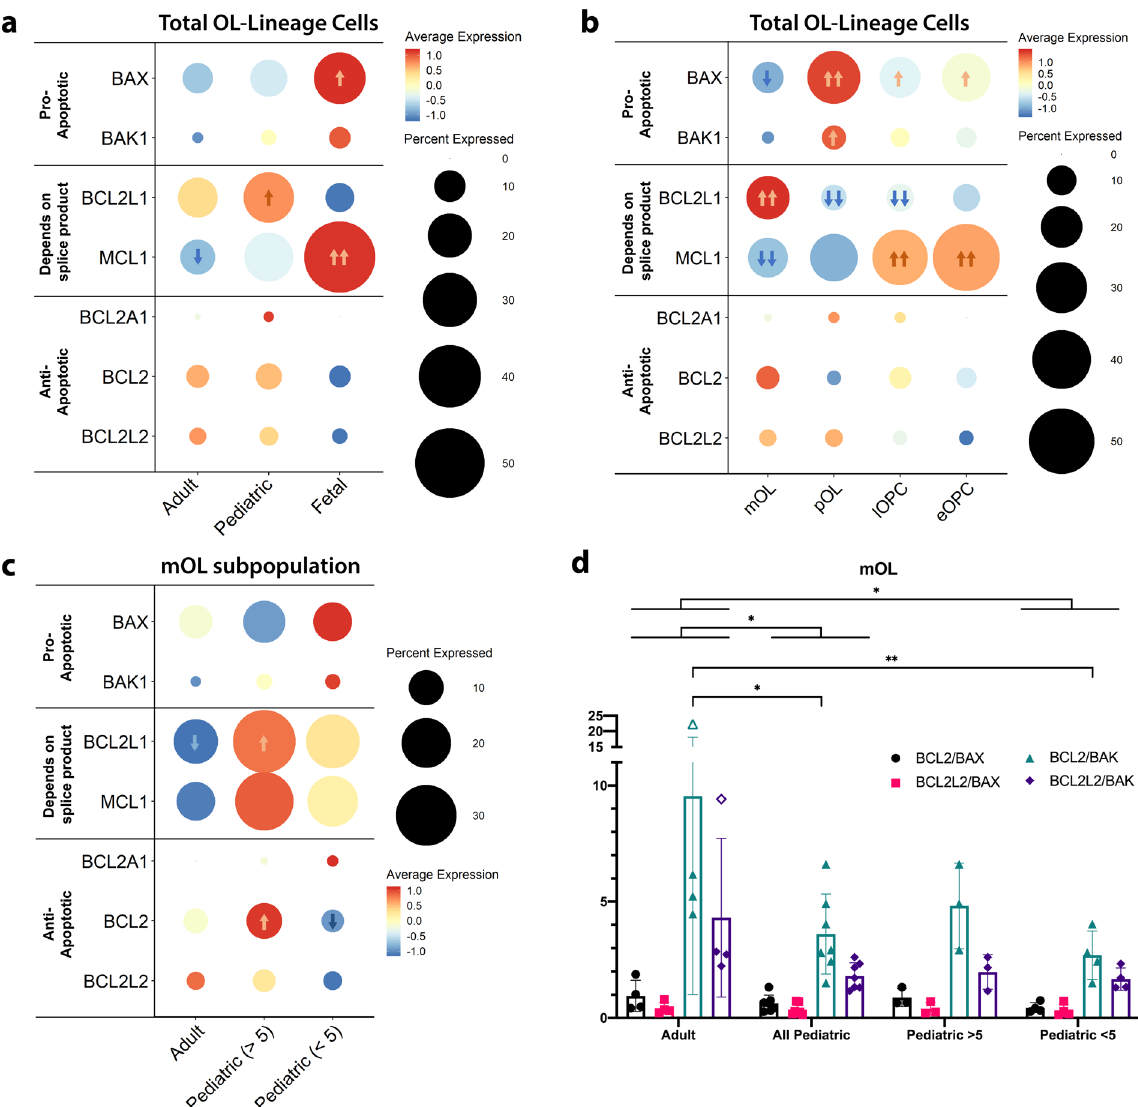
Fig. 3 Differential baseline BCL-2 family gene expression in adult, pediatric and fetal OL-lineage cells. a – c Relative expression of pro and anti-apoptotic BCL-2 family genes across OL lineage spectrum in relation to age and lineage. Scale is z-scores of averaged normalized gene expression across the cell types or age groups; percent expressed indicates the percentage of OL-lineage cells in the category on the x -axis expressing the gene. Arrows indicate up- (orange) or down- (blue) regulation (adj. p < 0.05) against all other groups, where one arrow |logFC | > 0.1, two arrows |logFC | > 0.25, by Wilcoxon rank sum differential expression testing with Bonferroni correction. d Data indicates the ratios of average expression of individual pro- and anti-apoptotic genes for mature OLs. Data under all pediatric are combined from pediatric >5 and pediatric <5. Open circles indicate outliers by Grubbs ’ test. Comparison of summated and individual ratios between adult and all pediatric donors was done by two-way ANOVA with Sidak ’ s correction for multiple comparisons both with and without the outliers, * p < 0.05. Age group comparisons of summated and individual ratios between adult, pediatric >5, and pediatric <5 was done by two-way ANOVA with Tukey ’ s correction for multiple comparisons, both with and without the outliers, * p < 0.05, ** p < 0.01. Number